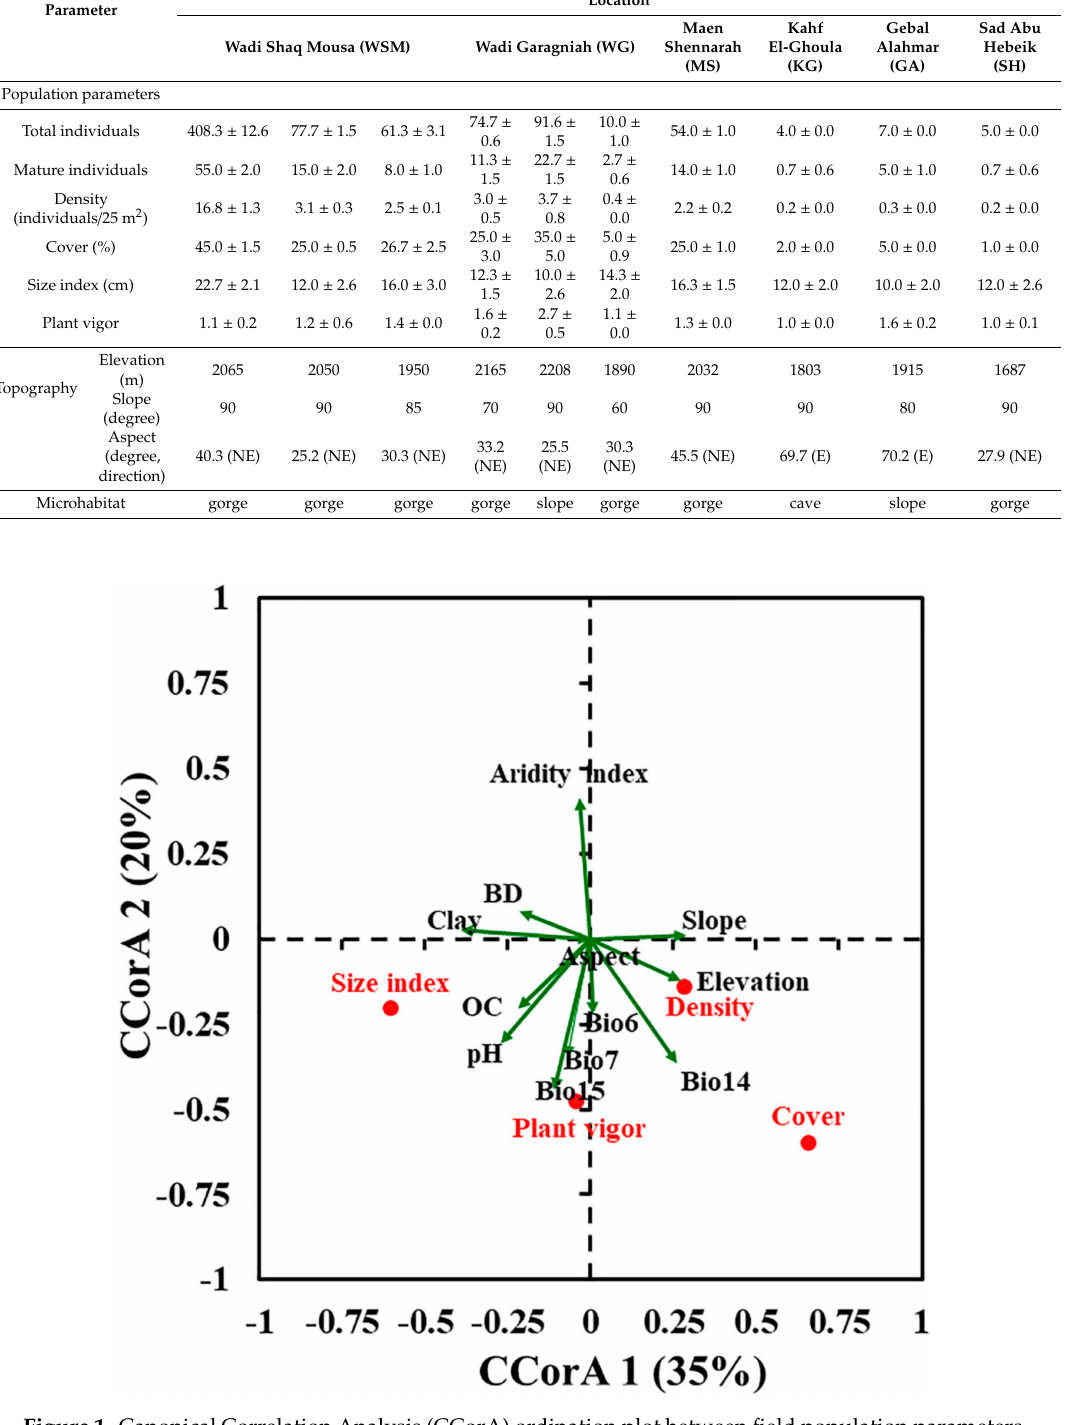
Figure 1. Canonical Correlation Analysis (CCorA) ordination plot between field population parameters (density, cover, size index, and plant vigor) and environmental variables. Variance percentages are indicated after the axes. Environmental variables include minimum temperature of coldest month (Bio6), temperature annual range (Bio7), precipitation of driest month (Bio14), precipitation seasonality (Bio15), organic carbon (OC), and bulk density